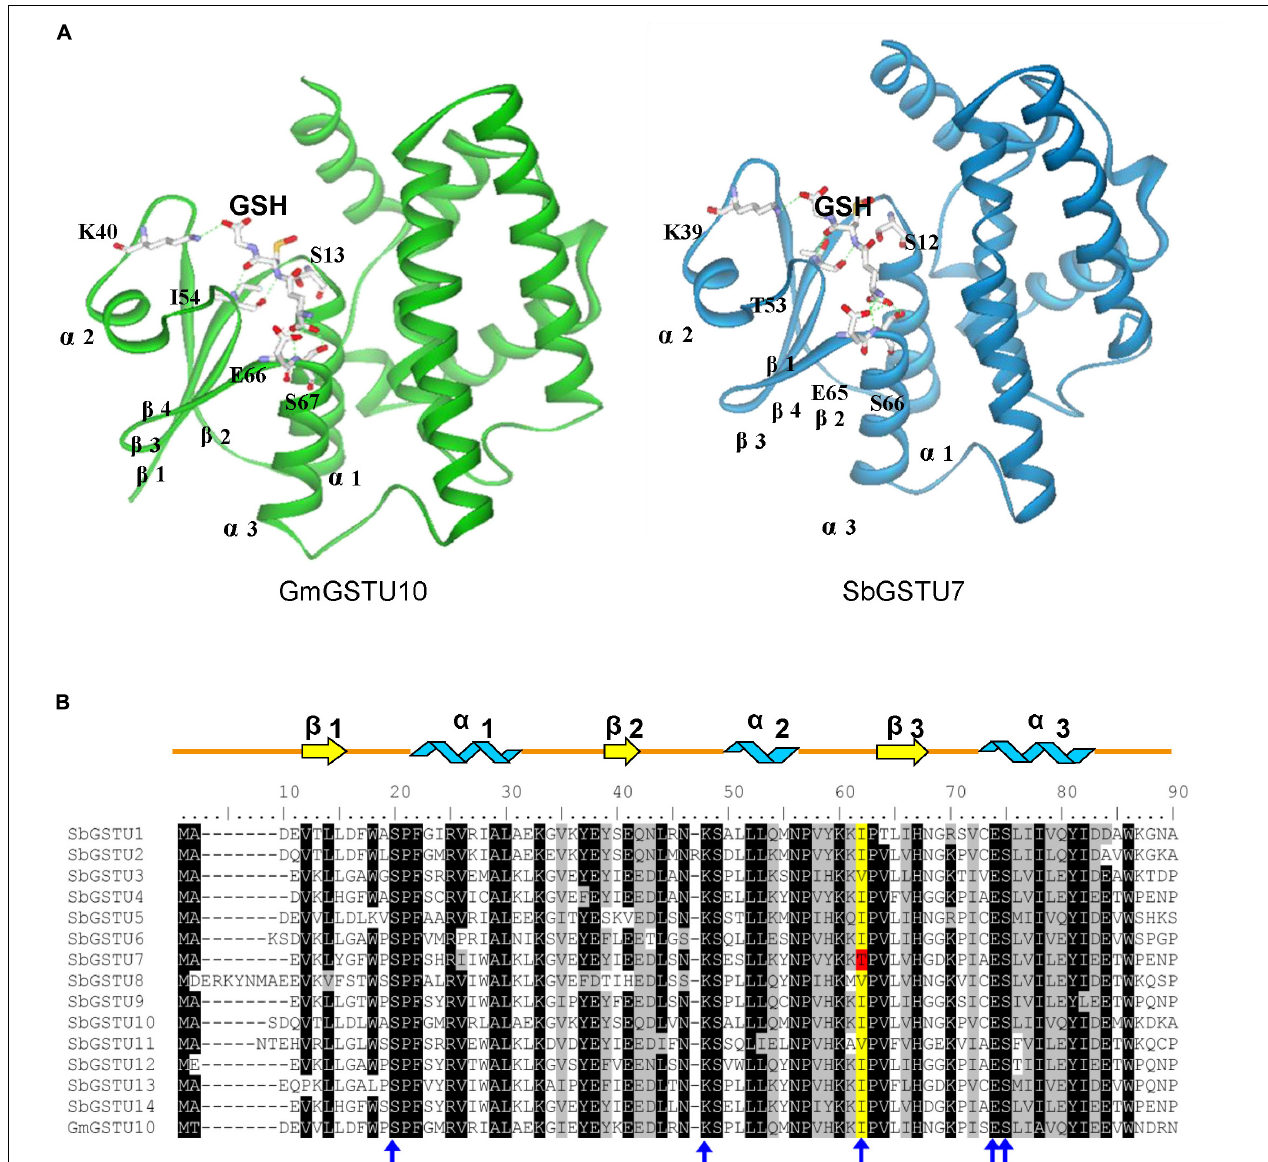
FIGURE 6 | Structural comparison of G-site residues (A) and N-terminal amino acid sequence alignment of the Salix tau GSTs (B). The structure of GmGSTU10 (template, PDB No. 4CHS) and SbGSTU7 (stimulated) are presented in (A) . The amino acid structures of GSH-binding sites are shown with sticks. In (B) , the conserved amino acids are shaded with black and gray. The G-sites of SbGSTU7 are marked with blue arrows. One conserved residue of G-sites (Ile/Val, alignment position 62) is shaded with yellow and the Thr substitution in SbGSTU7 of this residue is shaded with red. Alpha helices and beta strands are represented as blue ribbons and yellow arrows,